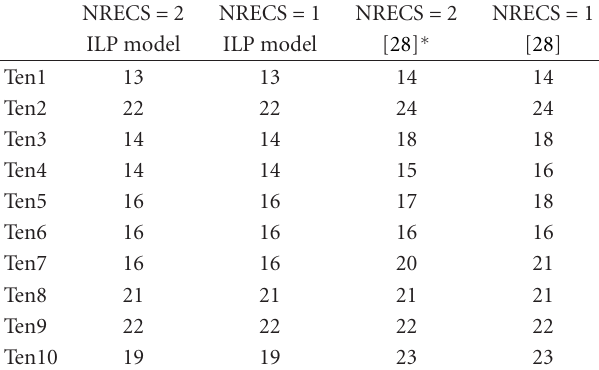
Table 3: ILP results